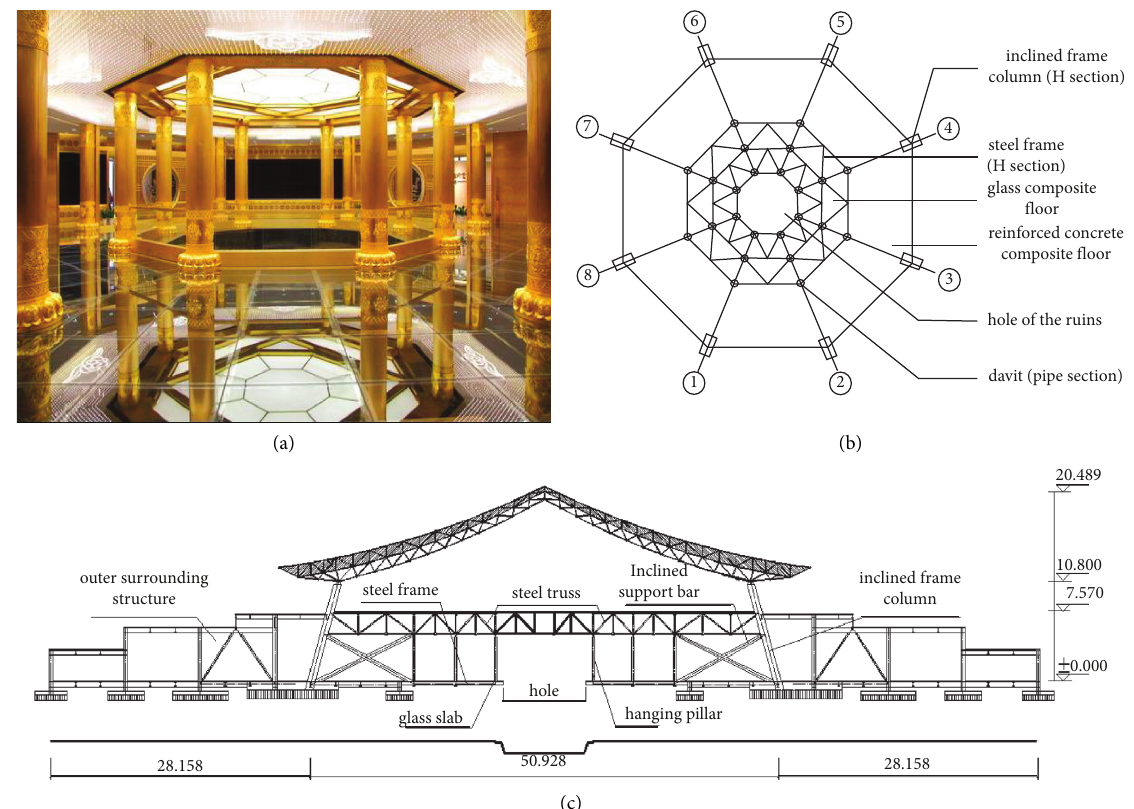
Figure 1: Diagram of main structure of the Mingtang Hall. (a) The steel space frame-glass composite floor. (b) Diagram of the lower layer in plan view. (c) Profile of main structure of the Mingtang Hall (m).